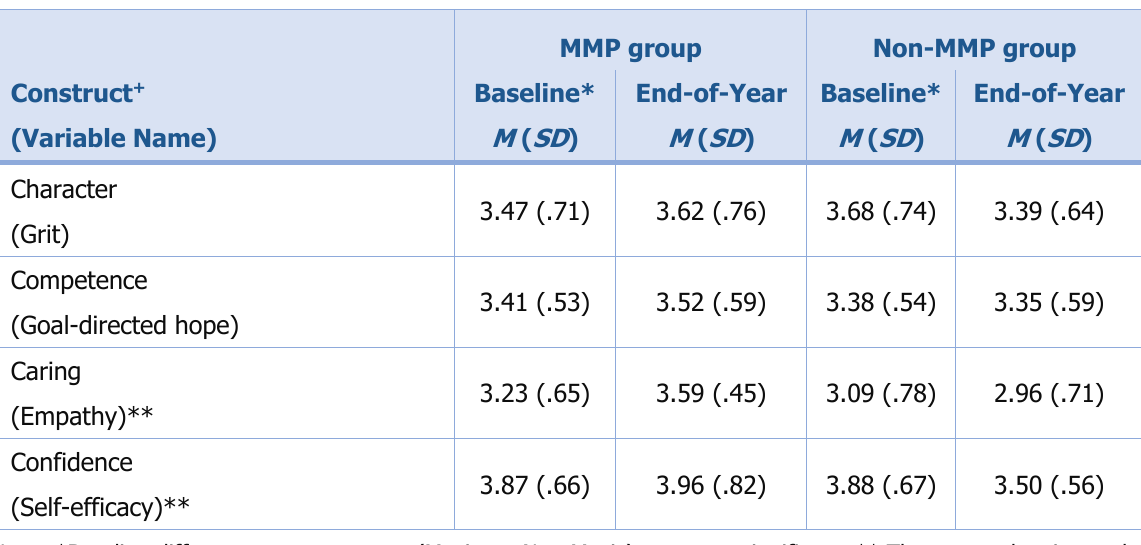
Table 5. Baseline and End-of-Year Mean Scores by Group